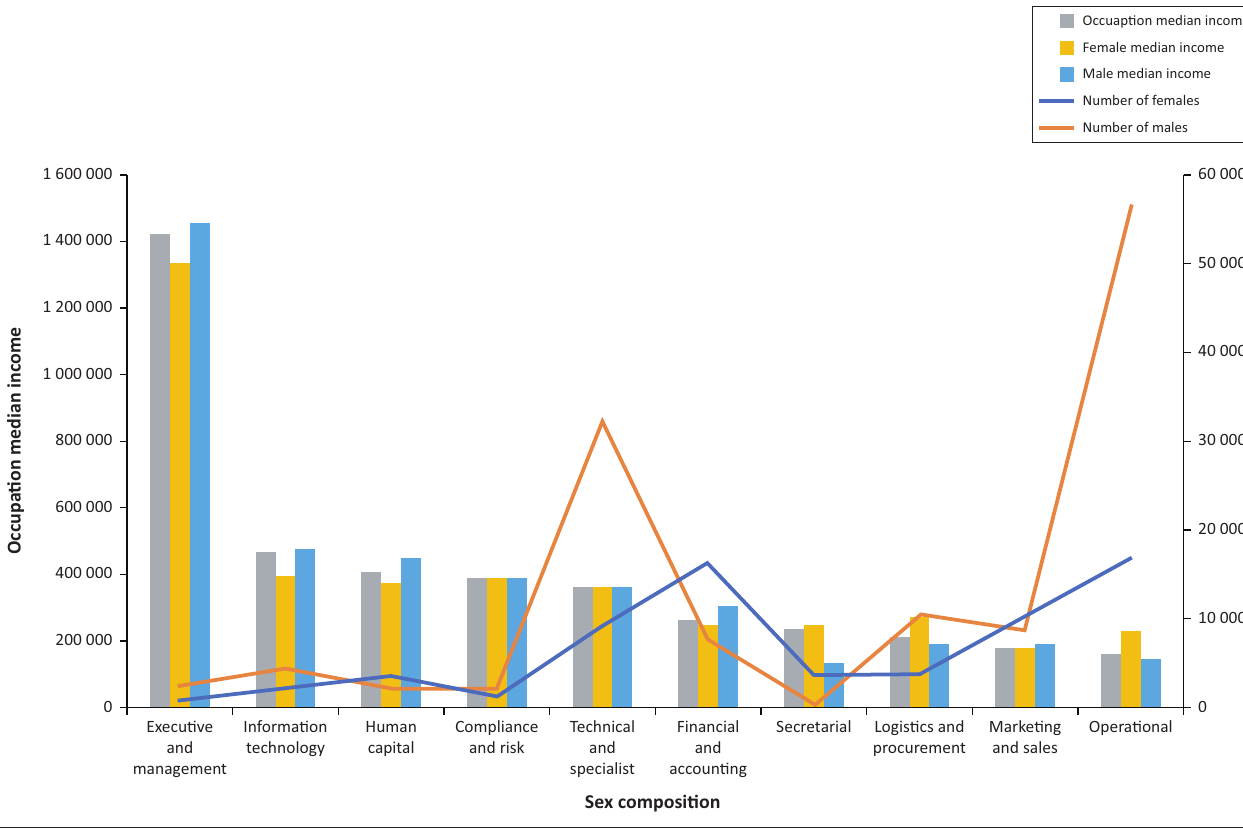
FIGURE 2: Occupation median income and sex